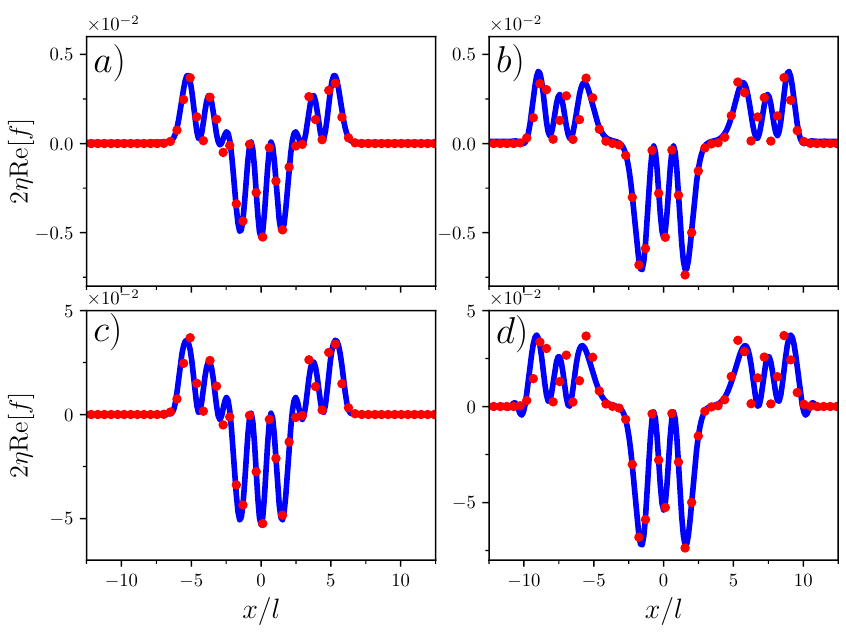
Figure 2: Time evolution of the density of the Bose gas, n ( x , t ) /ρ − 1, in a ring. A solution of the GPE is shown by the solid blue curves; the linearized solution is presented using red dots. The perturbation potential is given by Eq. (27). Numerical calculations are implemented for N = 1500, g = 1.0 The density of the Bose gas at t = 0 is ρ = 50 / l , which ensures that ξ (cid:28) l . Panels (a) and (b) show the snapshots at t ≈ { 3.5 and (d) demonstrate the densities at t ≈ { 3.5